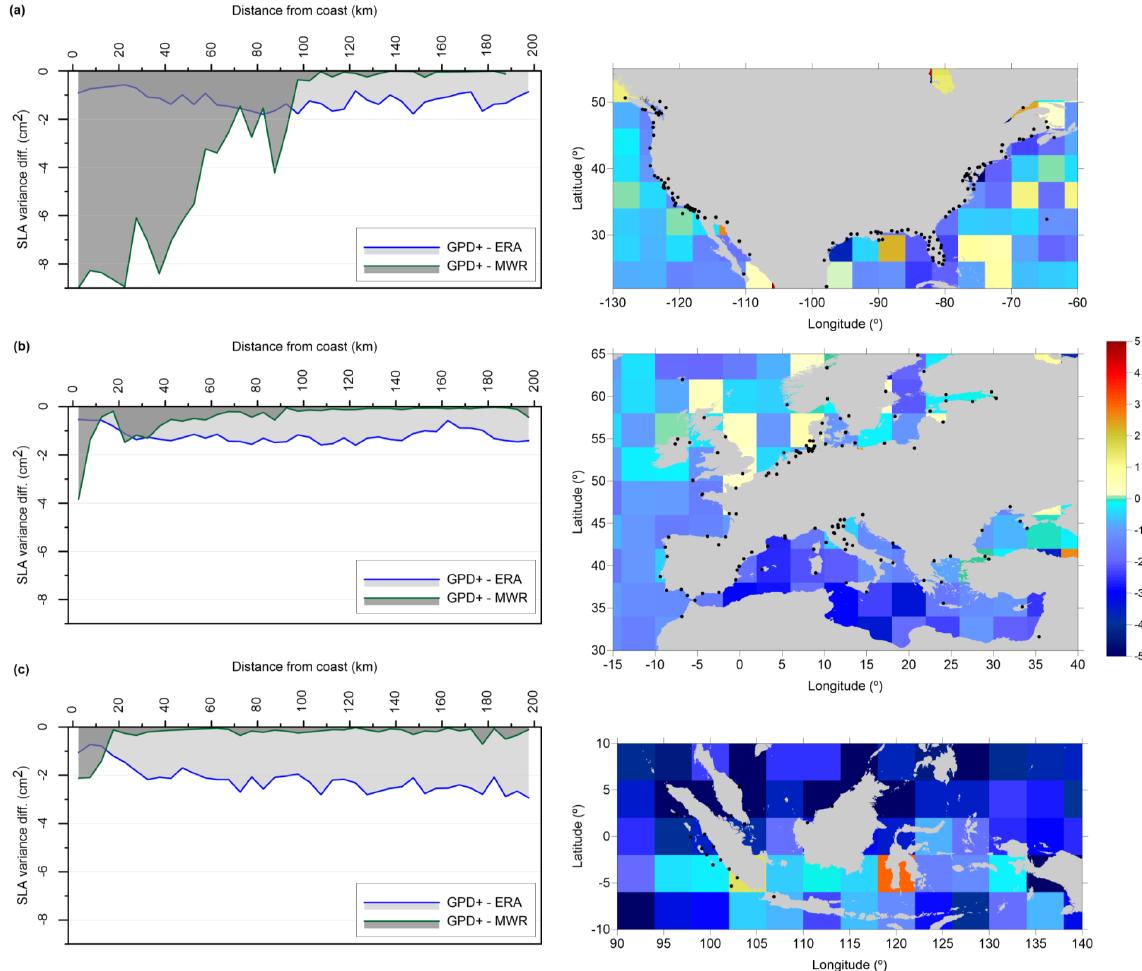
Figure 14. Variance differences (cm 2 ) of SLA as a function of distance from the coast (left) between GPD + and ERA-Interim WTCs (blue) and GPD + and MWR-derived WTCs (green) for the whole Envisat period (cycles 6 to 113) for the North American coast (a) , European coast (b) and Indonesia region (c) . In the plot for the North American coast, the y axis has been clipped to − 9cm 2 (minimum value is around − 13cm 2 ). Right panels show the spatial distribution of the weighted SLA variance differences (in cm 2 ), computed along the satellite tracks, between GPD + and ERA-Interim WTCs. The green colour represents SLA variance differences around zero. The GNSS stations used in the computation of the GPD + WTC are represented as black